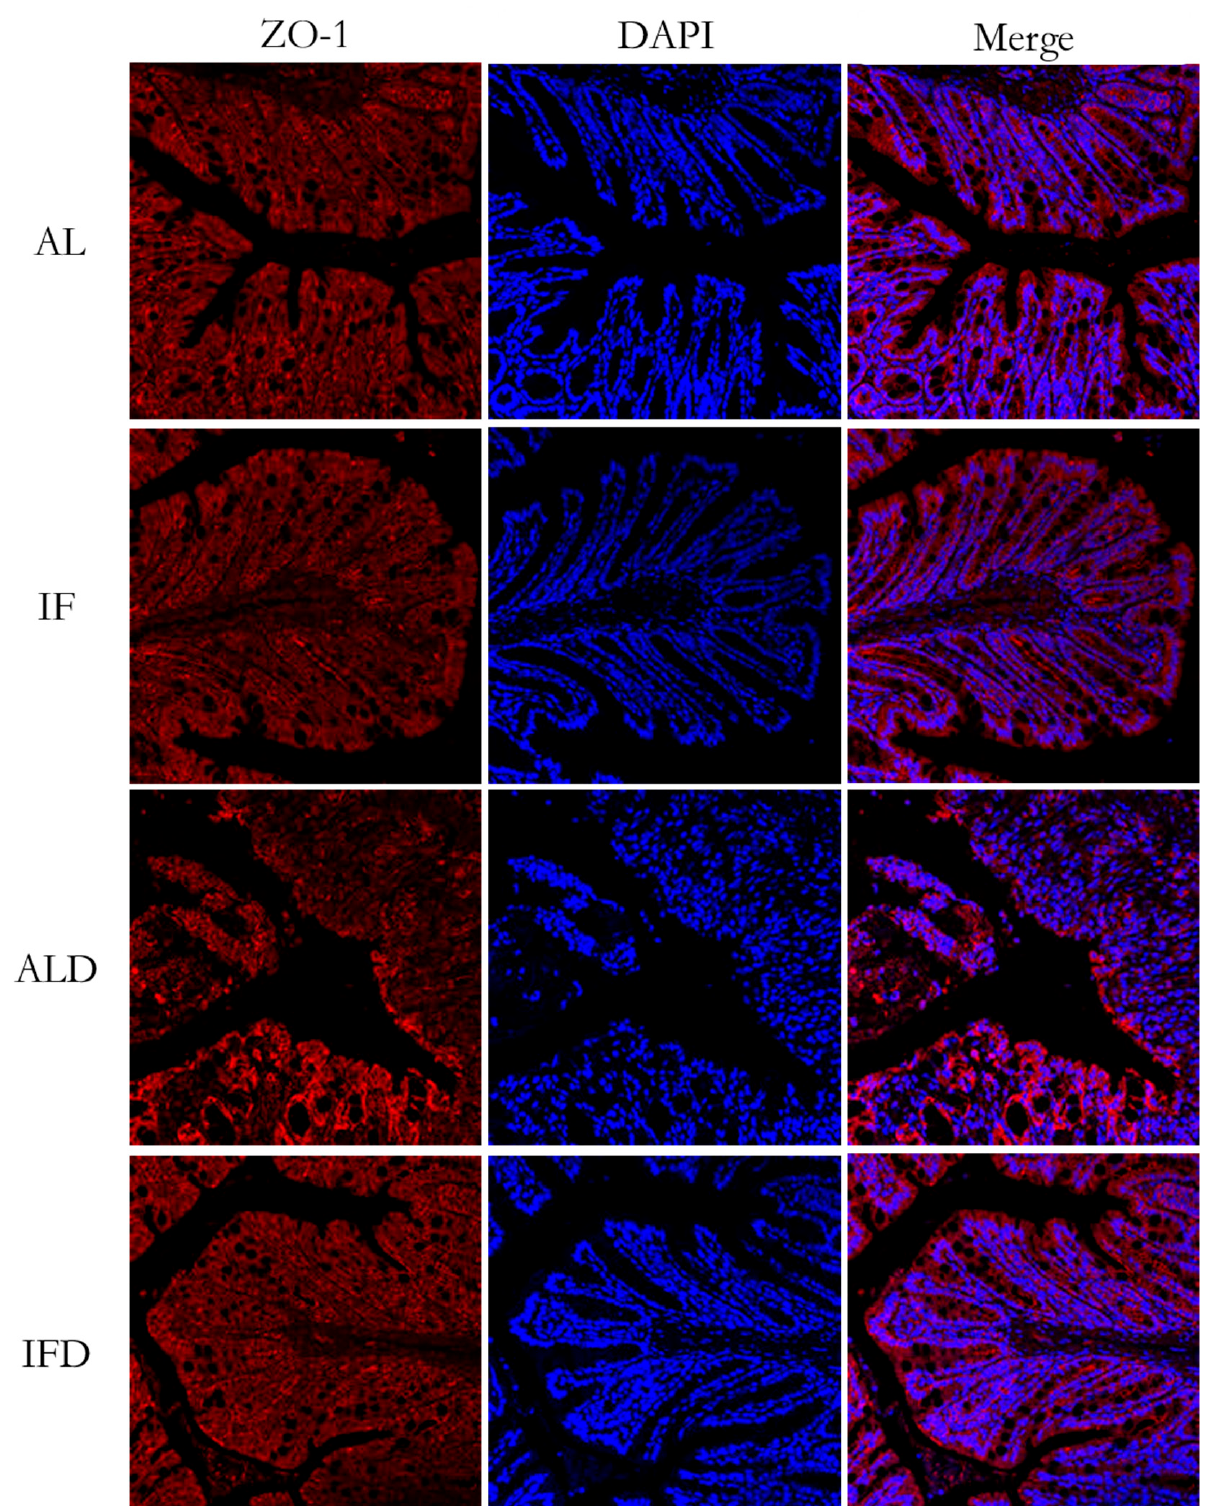
Figure 7. IF alleviates gradual intestinal barrier impairment: Representative colon histology was assessed by ZO-1 immunofluorescence staining. AL: ad libitum-fed group; IF: intermittent fasting group; ALD: ad libitum-fed group with DSS; IFD: intermittent fasting group with DSS.